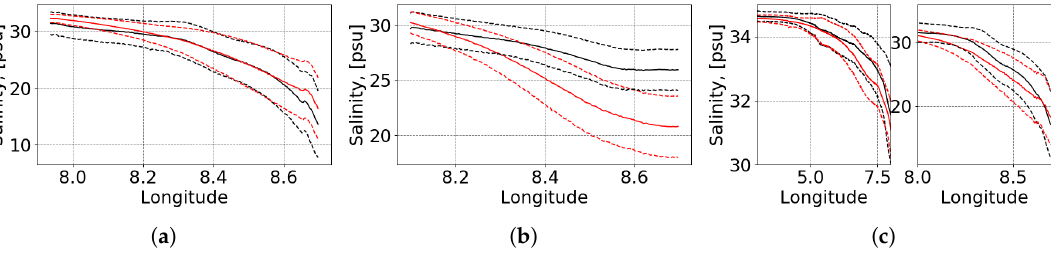
Figure 9. Mean sea-surface salinity from the three ferry lines (black lines) and corresponding model values (red lines). Mean values are shown by solid lines; mean values ± one standard deviation are shown by dashed lines. Ferries: ( a ) Cuxhaven–Helgoland; ( b ) Büsum–Helgoland; and ( c )